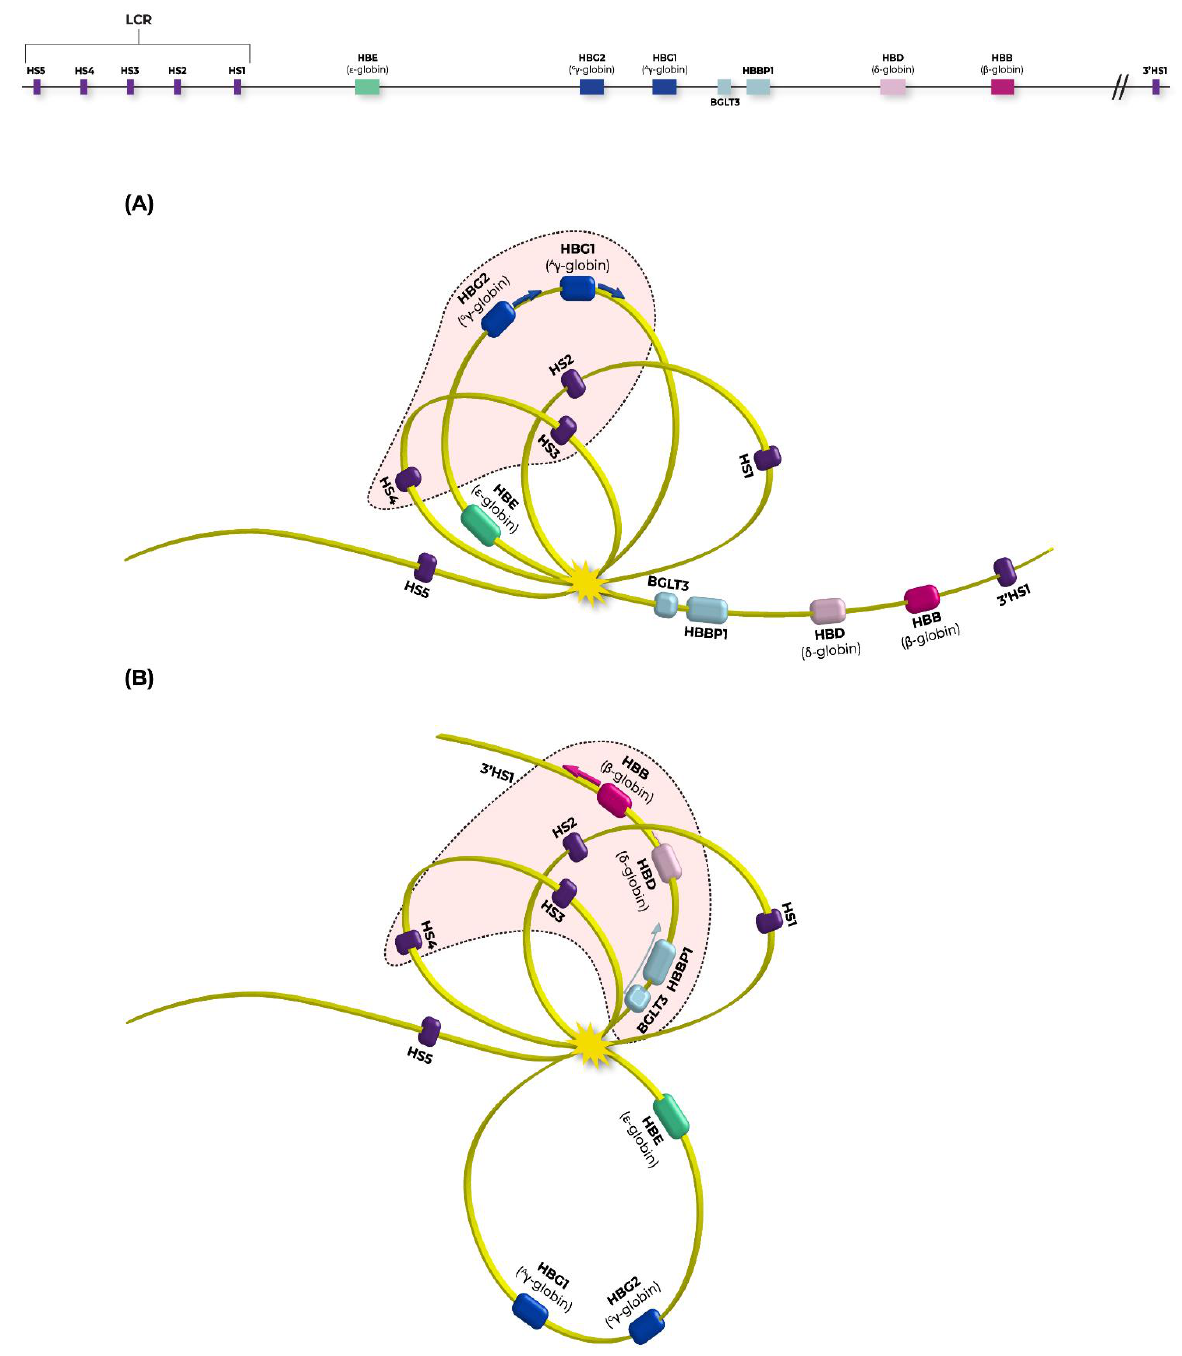
Figure 4. Updated looping model illustrating fetal (HbF) to adult hemoglobin (HbA) switch. ( A ) At fetal stage DNA loops promote the proximity of HBG2 and HBG1 ( γ -globin genes) to DNAse Hypersensitive Sites (HS2, HS3 and HS4) favoring HbF expression. ( B ) During HbF to HbA transversion BCL11A and LRF (not shown for satisfying model’s simplicity) bind HBG2/1 promoter regions, leading to their full silencing. Simultaneously, LRF promotes BGLT3 -lncRNA expression, further releasing downstream chromatin conformation, thus supporting HBB expression (for detailed analyses refer to discussion). The chromatin loop containing both fetal genes ( HBG2 and HBG1 ) interacting with HS2, HS3 and HS4 LCR enhancer sites, has been now replaced with the “adult”-genes’ loop including BGLT3 , HBBP1 , HBD and HBB genes. Chromatin modulation stimulates HbA expression at the adult stage. Arrows derived from genes indicate transcription. Yellow star represents the anchor gathering S/MAR elements of “ HBB